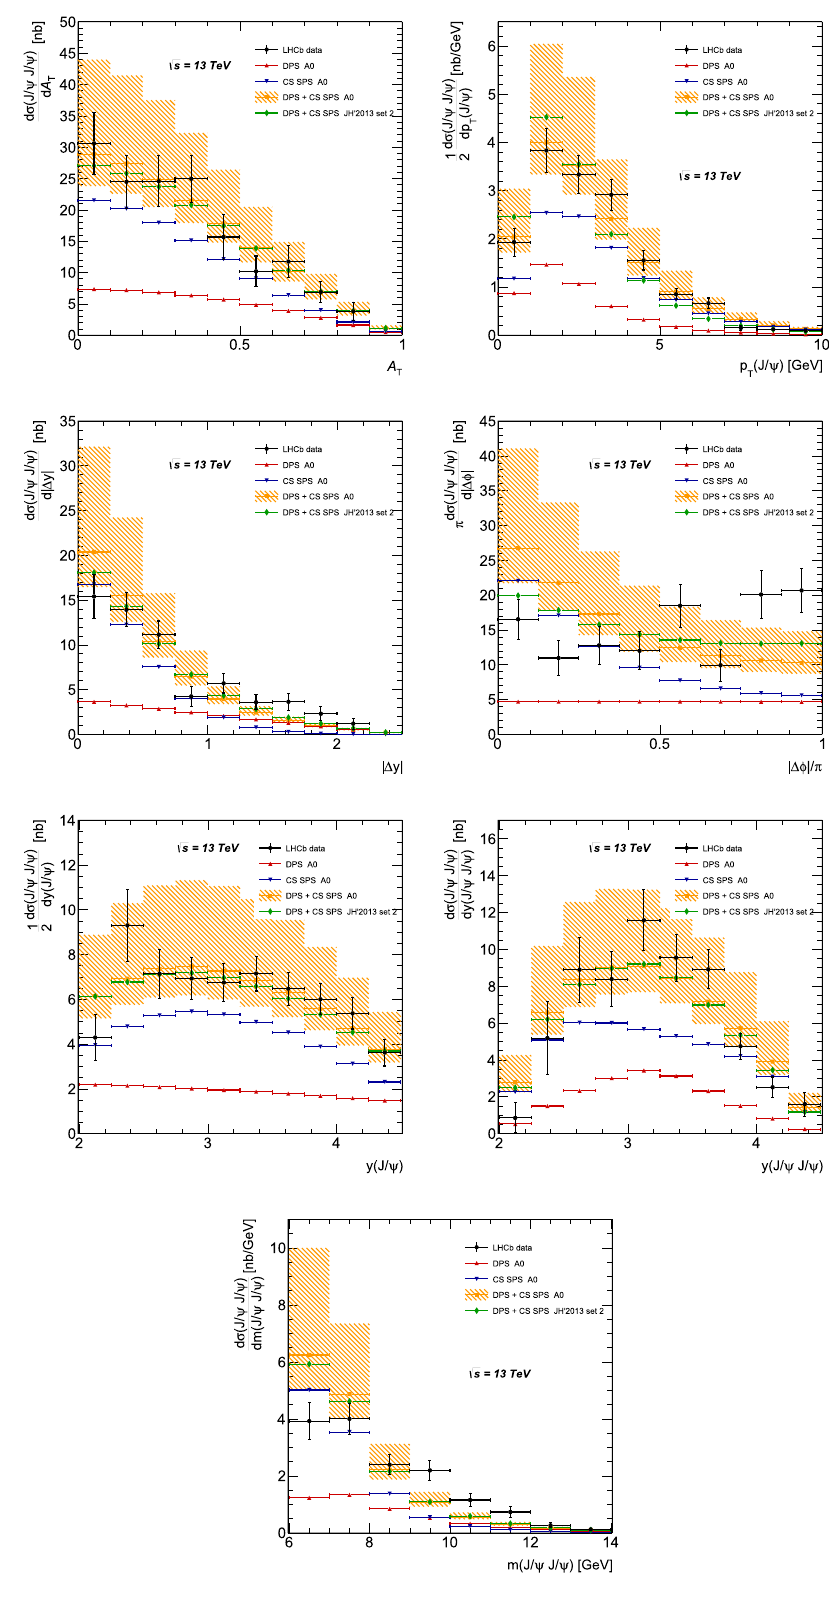
Fig. 8 Prompt double J /ψ production cross sections as functions of different kinematical variables calculated √ s = 13 TeV. The at kinematical cuts applied are described in the